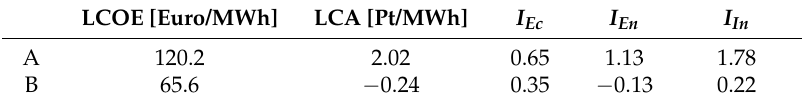
Table 5. Values of eco-efficiency indicators of the analysed agricultural biogas